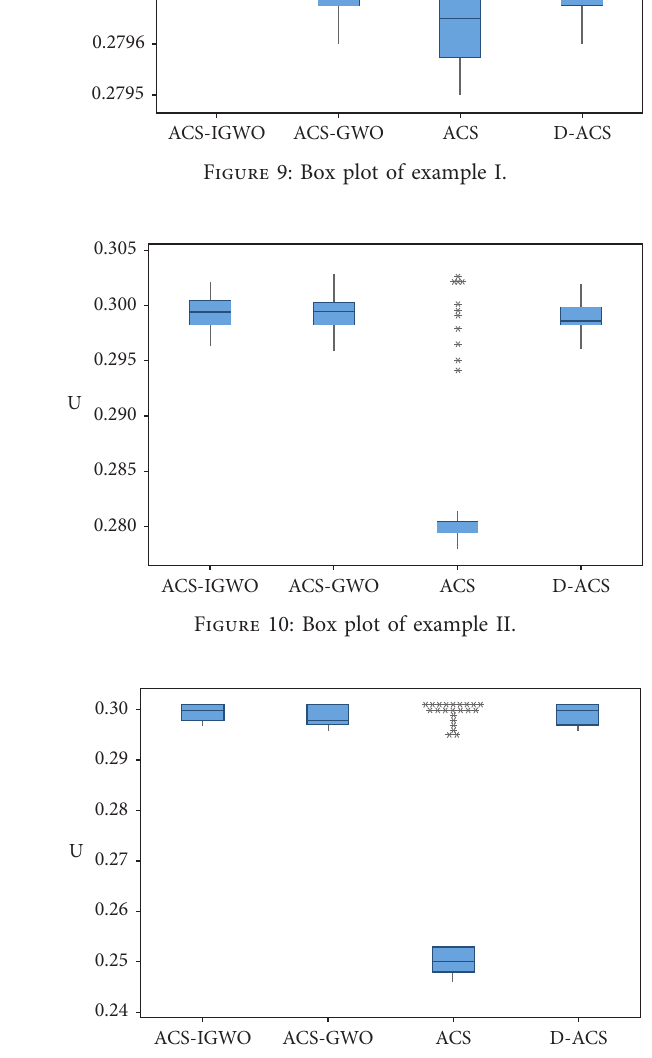
Figure 11: Box plot of example